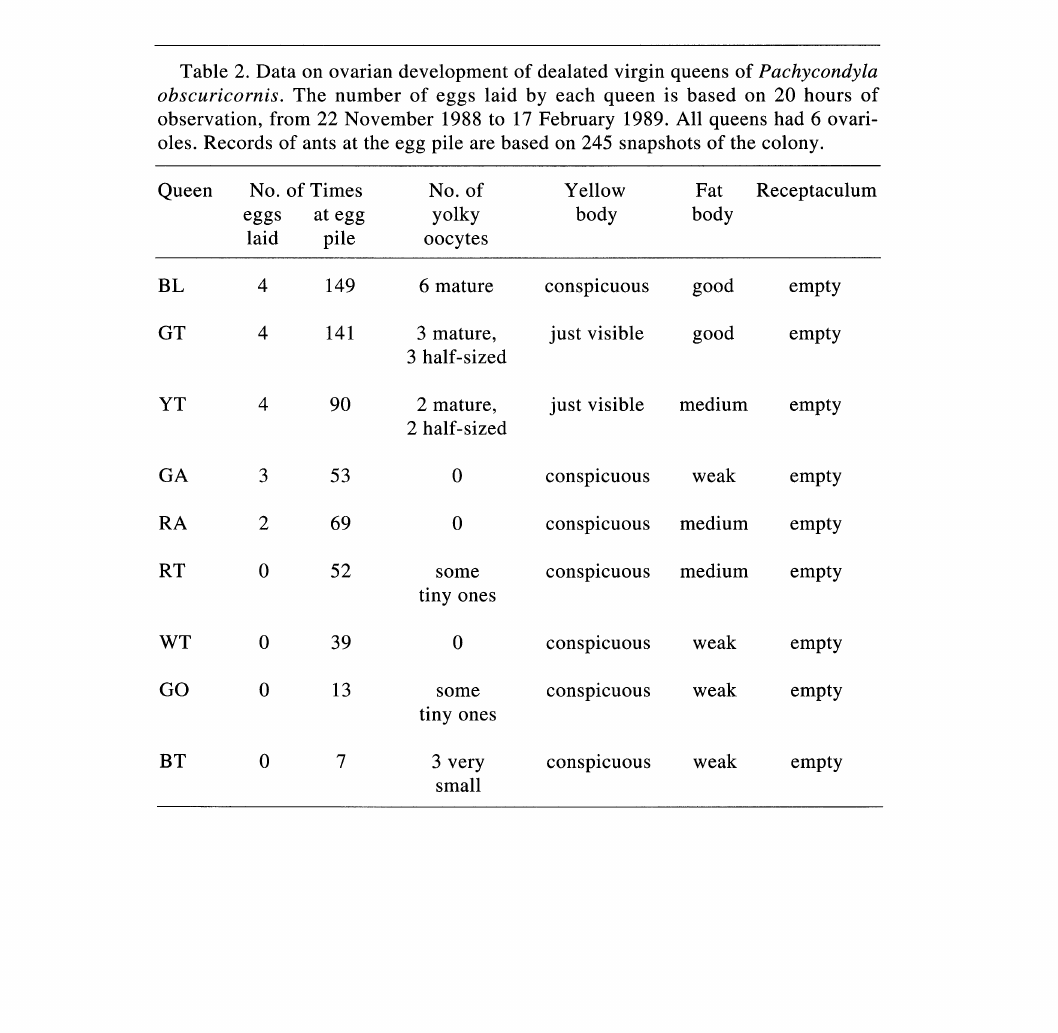
Table 2. Data on ovarian development of dealated virgin queens of Pachycondyla obscuricornis. The number of eggs laid by each queen is based on 20 hours of